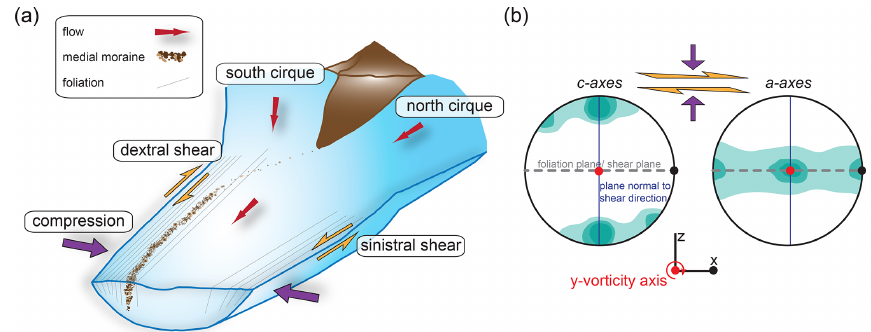
Figure 10. (a) Schematic of the combination of simple shear and compression experienced by the ice as the valley narrows (similar to Storglaciären) and (b) associated schematic CPO plots (for marginal ice), highlighting the relationship of the CPO to the foliation or shear plane (gray), the vorticity axis (red) and the plane normal to the shear direction (navy blue), expected for dynamic recrystallization at low strain rates and high